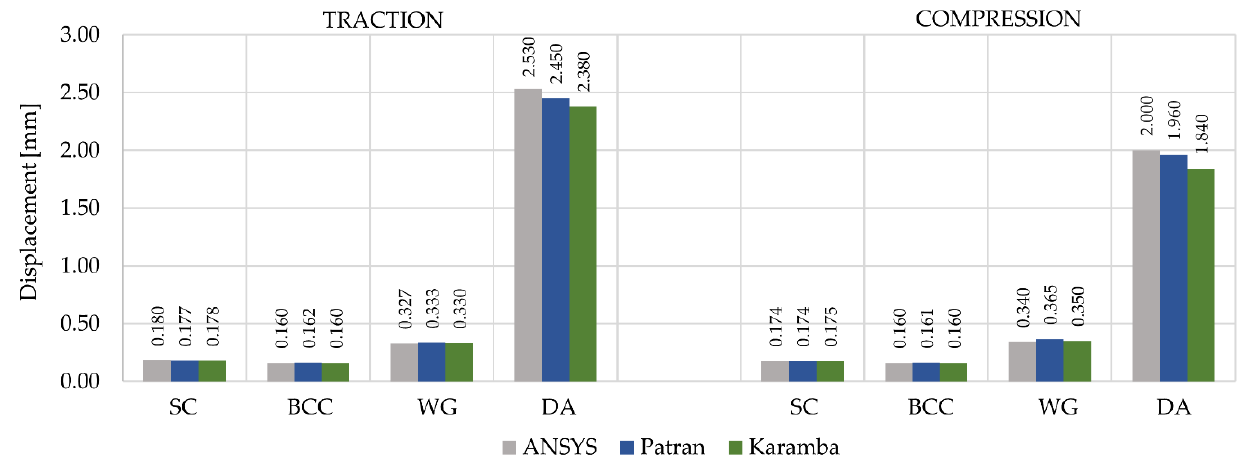
Figure 10. Displacement results of the traction and the compression load cases, according to the FEM software.